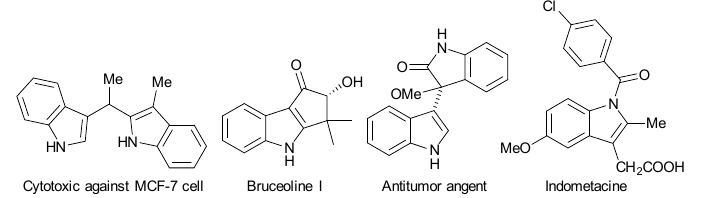
Figure 1. Representative drugs and biologically active compounds bearing indole unit.